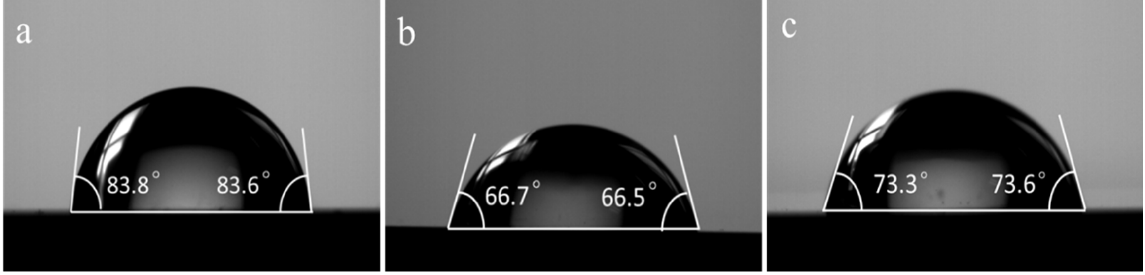
Figure 4. Contact angle images of ( a ) pure Zn, ( b ) Zn-0.3GNS, and ( c ) Zn-0.7GNS composites. Table 1. Hemolysis rate and contact angle of various zinc matrix materials.